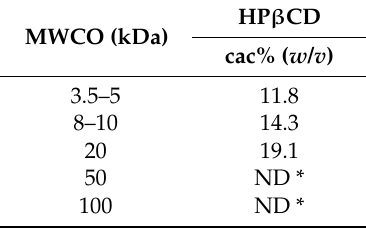
Table 2. Calculated apparent cac values for HP β CDs in pure water and different semi-permeable